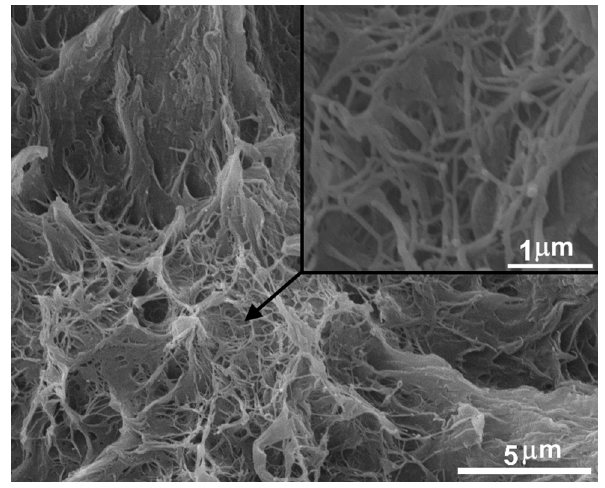
Figure 2. SEM of fibrillar structure of xerogel UHMWPE/1% FMWCNT.